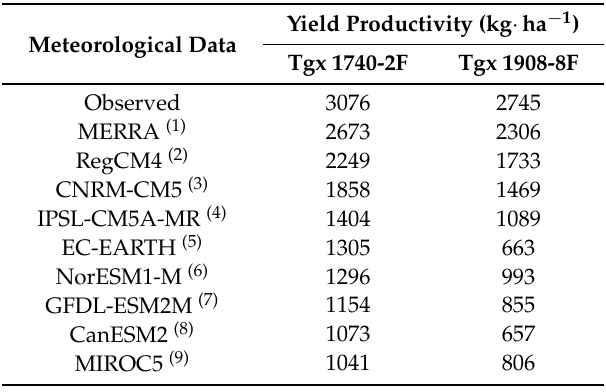
Table 6. Simulated average yield productivity values, for Tgx 1740-2F and Tgx 1908-8F cultivars in the